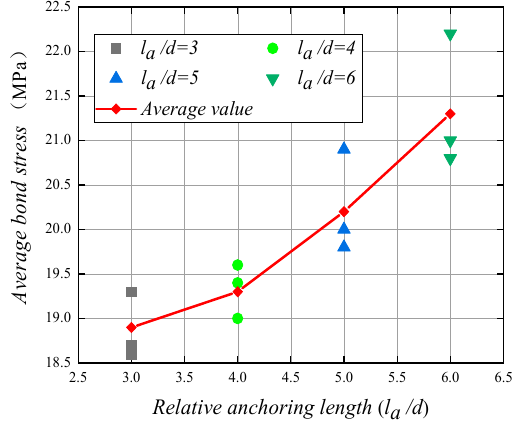
Figure 11. Relationship between bond stress and relative anchorage